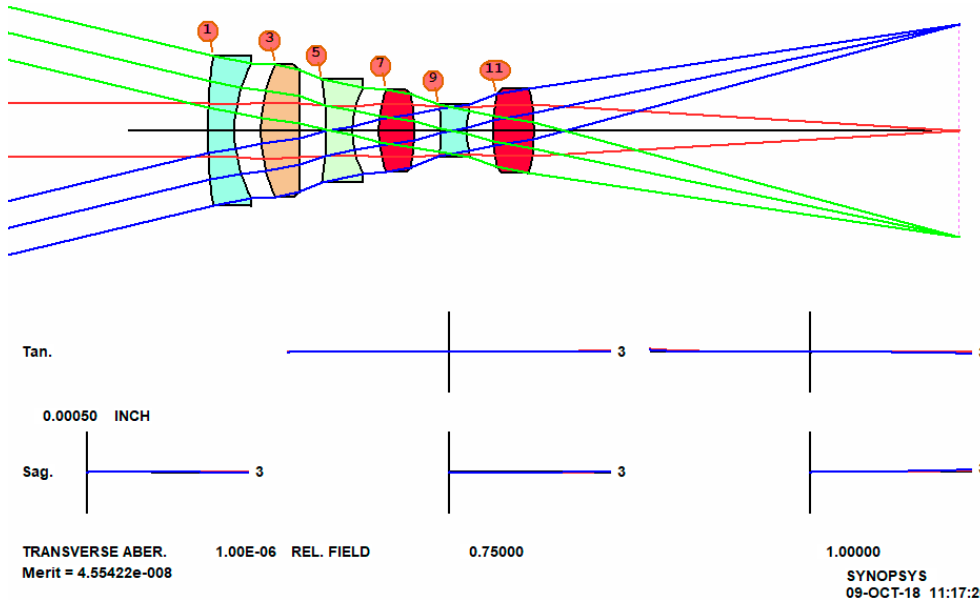
Figure 6. DSEARCH results for the camera lens.